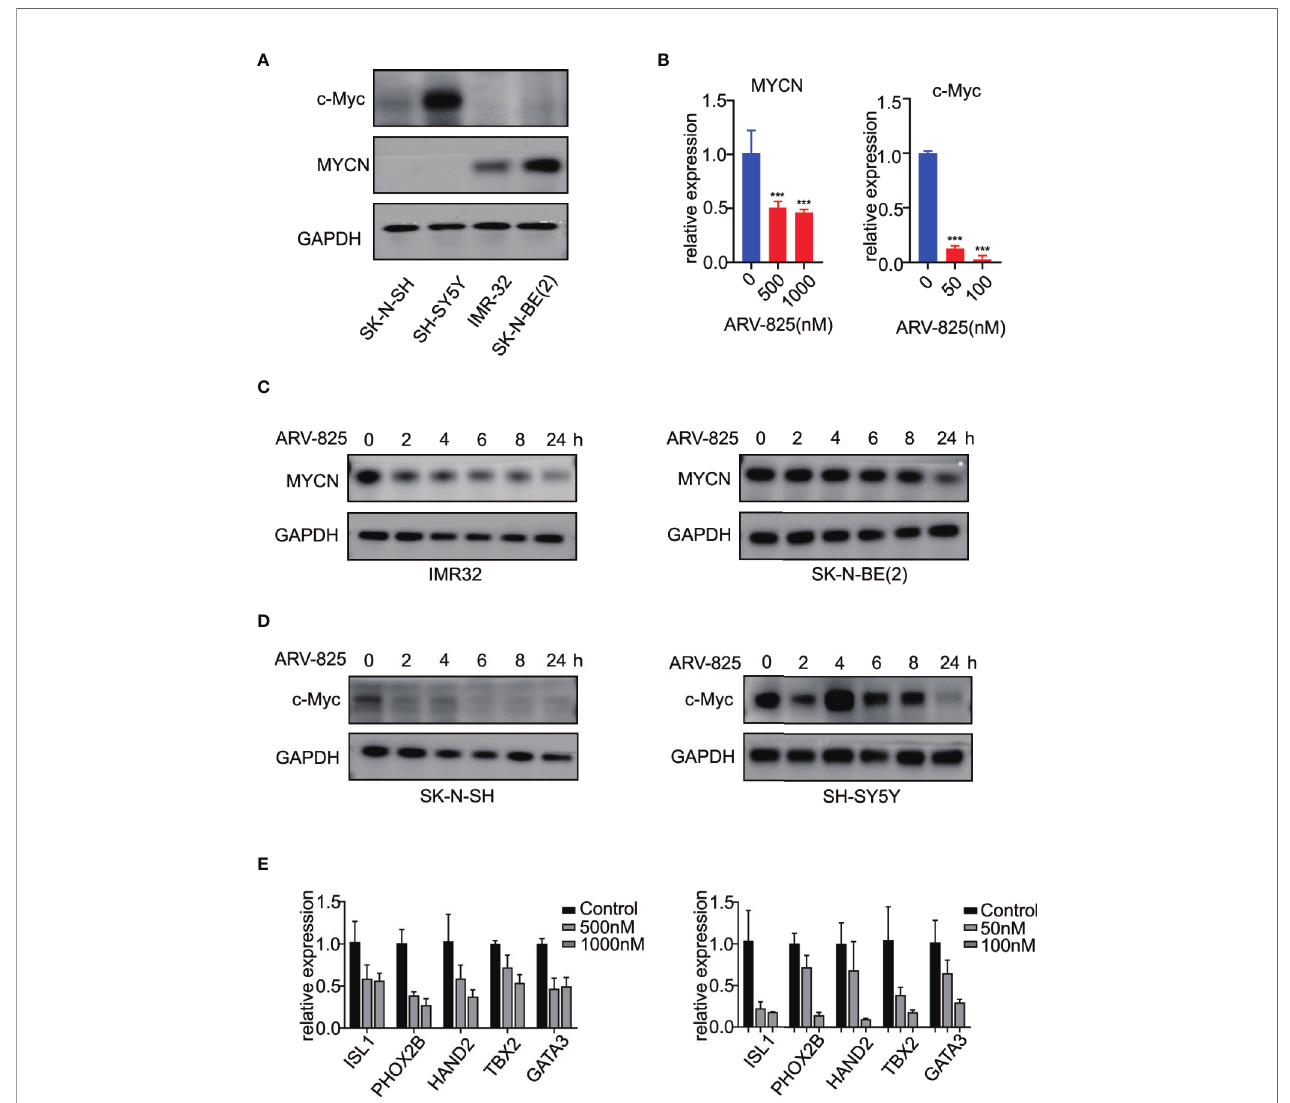
FIGURE 7 | ARV-825 suppresses MYCN/c-Myc expression and MYCN -associated super enhancers expression. (A) Western blot analysis showed MYCN and c- Myc protein levels in NB cells. (B) Real-time PCR analysis showed that ARV-825 induced suppression of MYCN and c-Myc mRNA relative expression [left: SK-N-BE (2) cells; right: SH-N-SH cells]. (C) Western blot analysis showed MYCN protein was downregulated by treatment with ARV-825 at different times in MYCN -ampli fi ed NB cells [left: IMR-32 cells treated by 10 nM ARV-825; right: SK-N-BE(2) cells treated by 500 nM ARV-825]. (D) Western blot analysis showed c-Myc protein was downregulated by treatment with ARV-825 at different times in MYCN non-ampli fi ed NB cells (left: SK-N-SH cells treated by 50 nM ARV-825; right: SH-SY5Y cells treated by 50 nM ARV-825). (E) Transcript level of MYCN -associated super enhancers was downregulated following ARV-825 treatment in SK-N-BE(2) cells (left) and SK-N-SH cells (right). *** p <